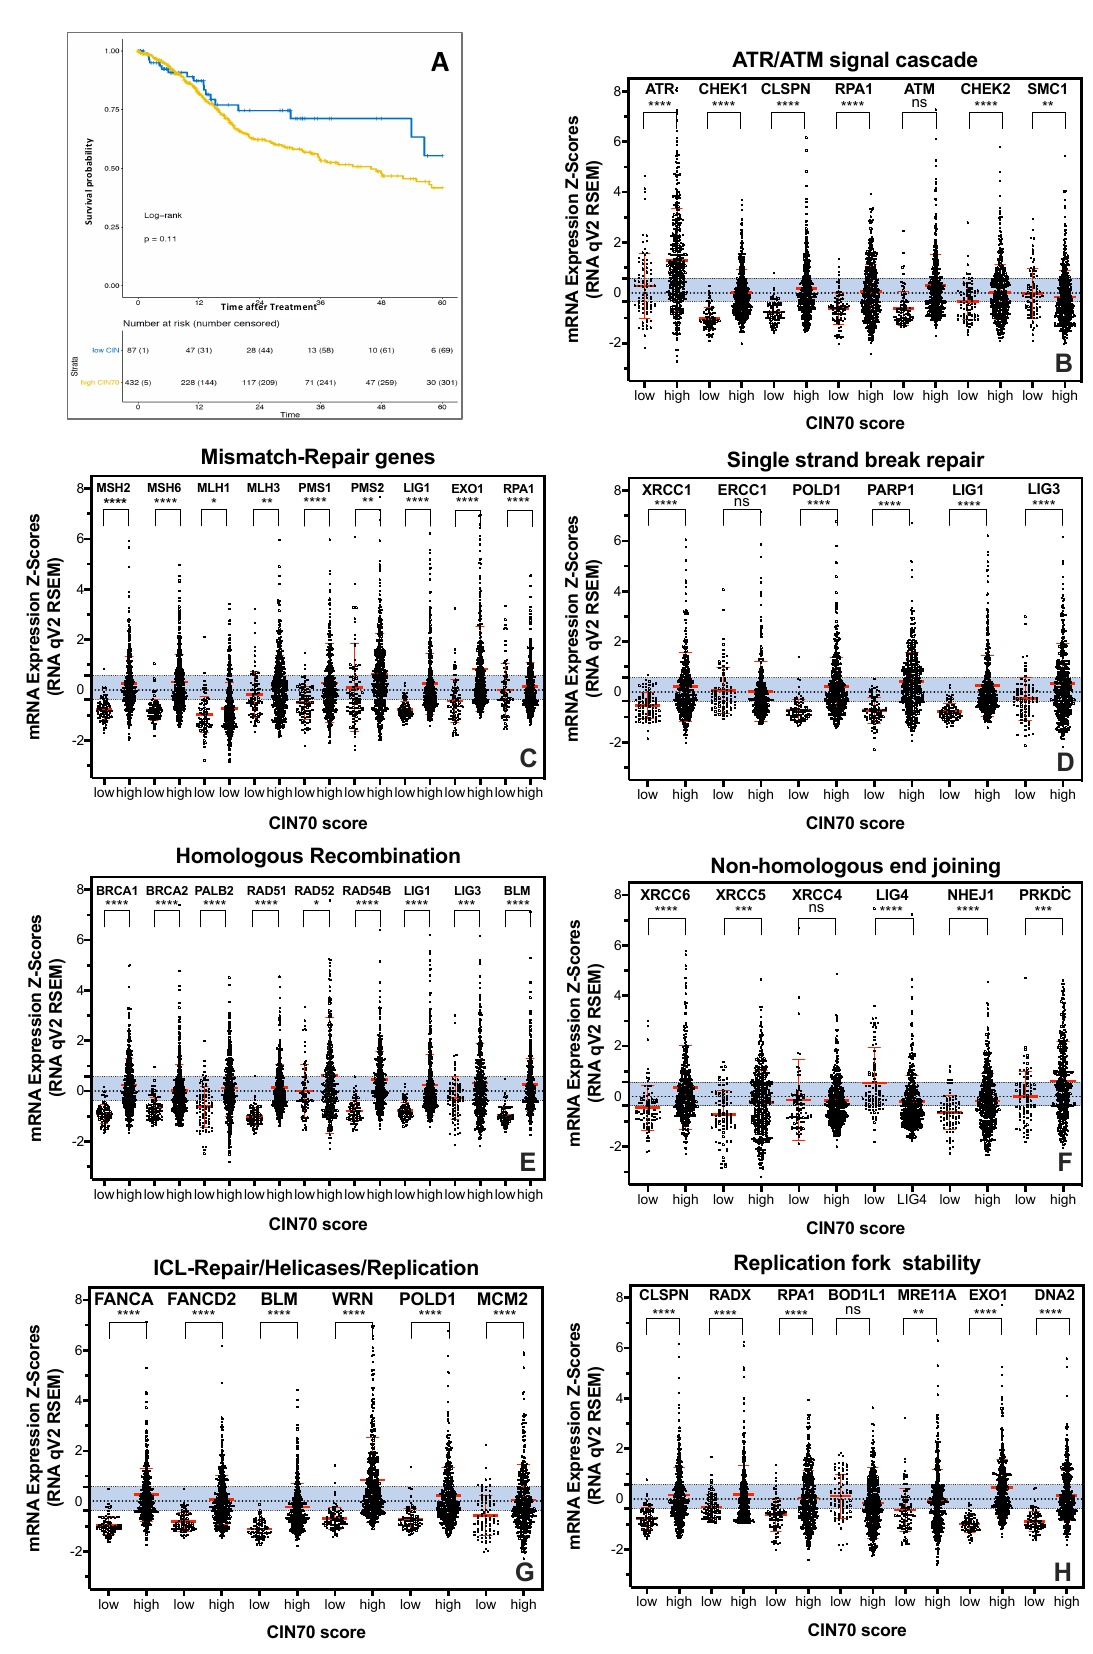
Figure 1. Functional aneuploidy indicates worse survival in HNSCC patients and is associated with high mRNA expression of DNA repair proteins. ( A ) Probability of survival after treatment of tumors with a low compared to a high CIN70